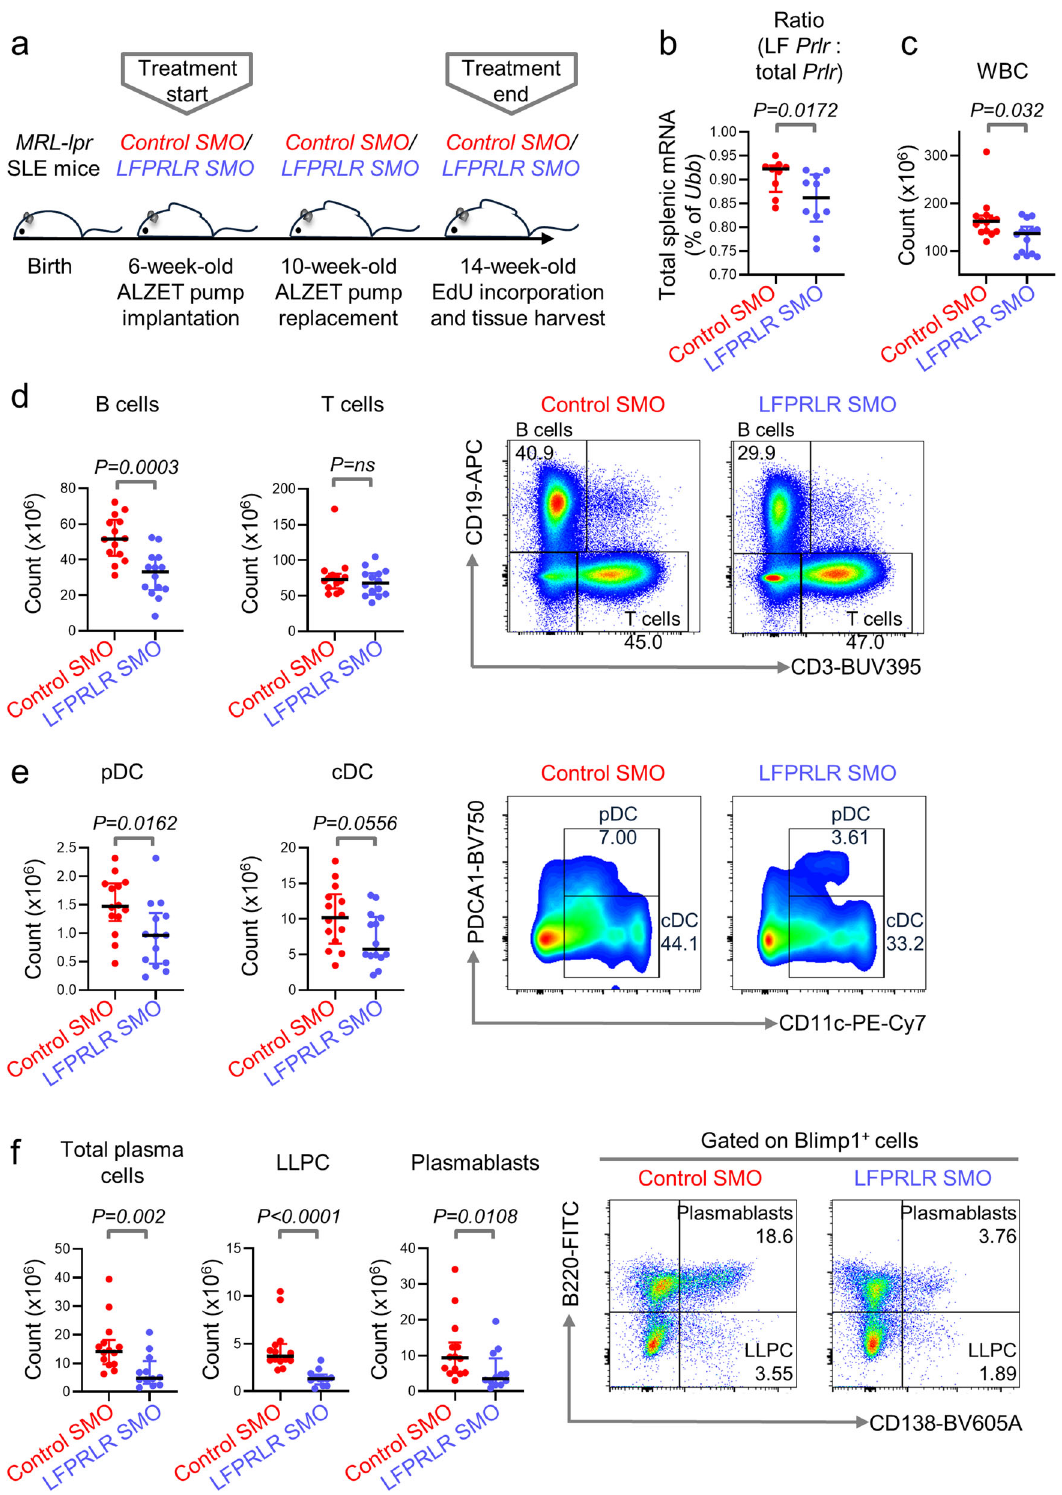
Fig. 1 Knockdown of LFPRLR reduces splenic B-cell subsets in SLE-prone mice. a – c Experimental design ( a ), veri fi cation of LFPRLR knockdown in total splenic WBCs by qPCR ( b ), and splenic WBC counts ( c ) in MRL-lpr mice treated with control SMO [ n = 9 for ( b ) and n = 14 for ( c ), red] or LFPRLR SMO [ n = 10 for ( b ) and n = 14 for ( c ), blue]. d – f Quantitation and representative fl ow cytometry plots of CD3 − CD19 + B cells and CD19 − CD3 + T cells ( d ); CD11c + PDCA1 + pDCs and CD11c + PDCA1 − cDCs ( e ); Blimp1 + CD138 + total plasma cells, Blimp1 + CD138 + B220 + plasmablasts, and Blimp1 + CD138 + B220 − long lived plasma cells ( f ) in spleens of MRL-lpr mice treated with control SMO ( n = 14, red) or LFPRLR SMO ( n = 12, blue). Graphs show median± interquartile range. Each dot in qPCR analyses of transcripts corresponds to the mean expression of that gene in one mouse calculated from 3 technical replicates. Ubiquitin B ( Ubb ) was used as the house-keeping gene in qPCR. Exact p -values were calculated using the Mann – Whitney U test. ns non-signi fi cant. COMMUNICATIONS BIOLOGY| (2023) 6:295